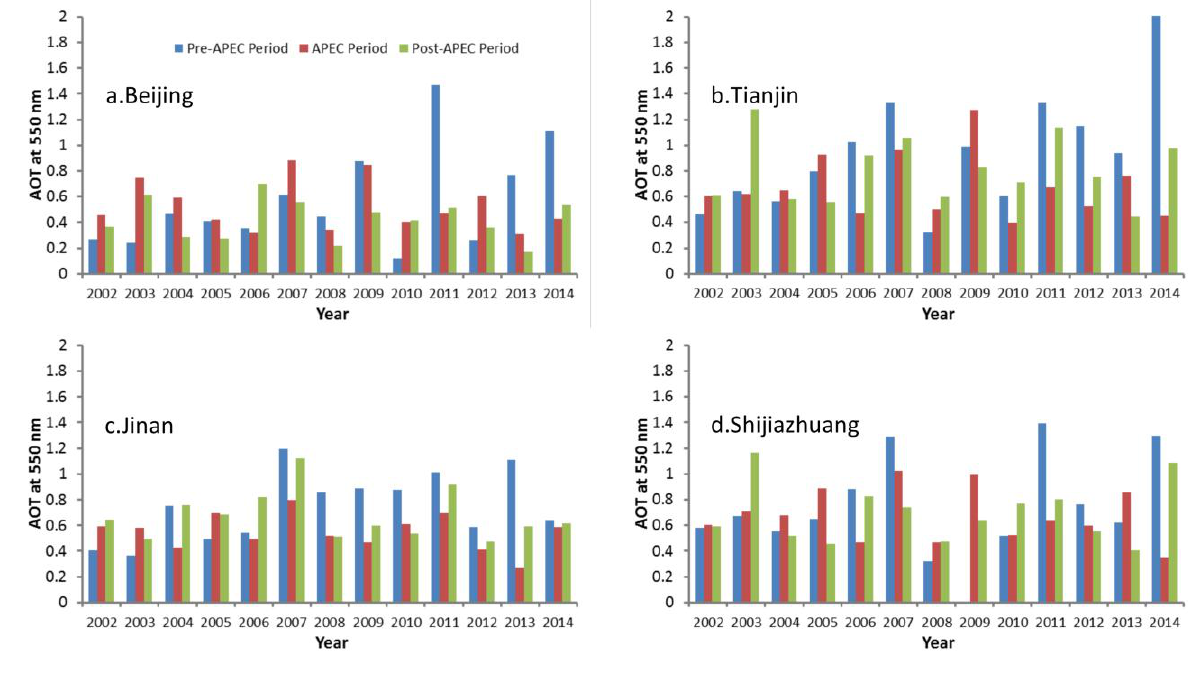
Figure 4. ( a ) MODIS mean AOT of 1–11 November 2014 (APEC blue period); ( b ) change in mean MODIS AOT values (1–11 November 2002–2013 minus 1–11 November 2014; positive values indicate increased air quality relative to historical mean; negative values indicate the opposite